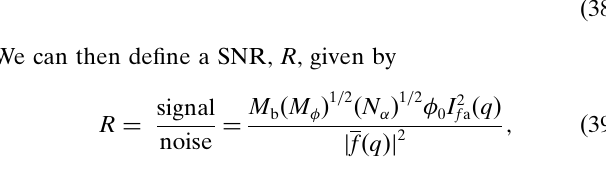
p and y ¼ c ffiffiffiffiffiffi N are a a ¼ 8517 (corresponding to a